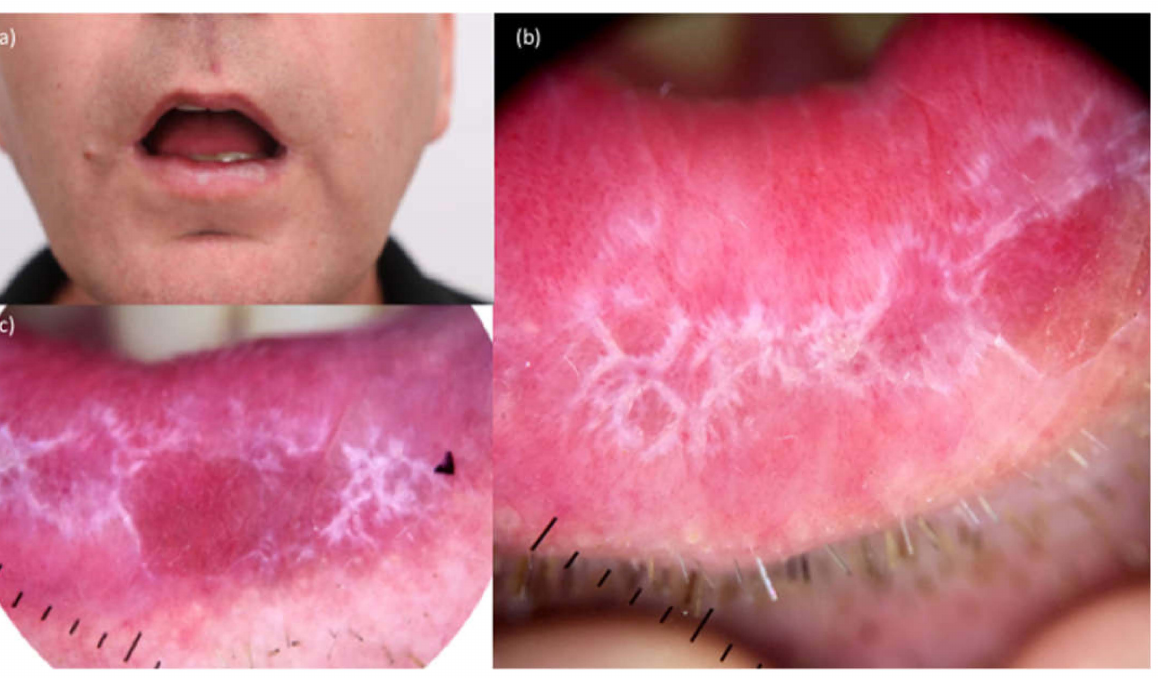
Figure 3. Clinical presentation ( a ) of an oral lichenoid reaction showing reticular features and Wickham’s striae ( b,c ) in a patient treated with Anti-PD1